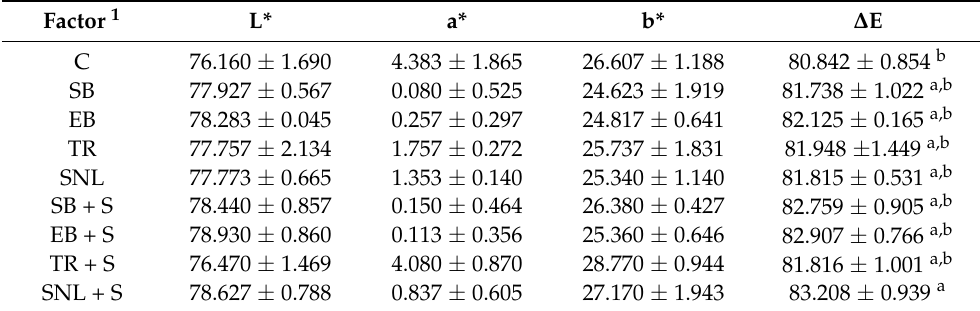
Table 5. L*a*b*, ∆ E, and standard deviations for each